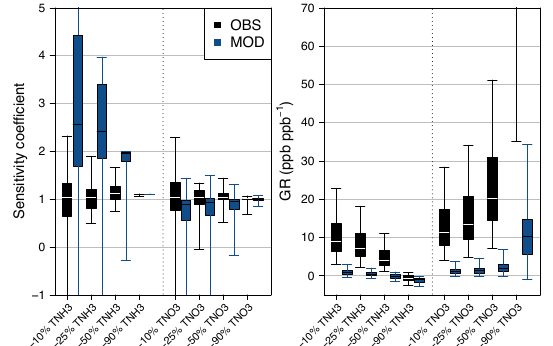
Figure 12. Sensitivity coefficient S x of nitrate formation due to dif- ferent changes ( − 10, − 25, − 50, and − 90%) in TNH 3 and TNO 3 concentrations (left panel) and resulting GR (right panel) during the period from 15 May to 10 September 2010. Experimental data (OBS) are in black, modeled data (MOD) in blue. Box plots indicate 5th, 25th, 50th, 75th, and 95th percentiles.